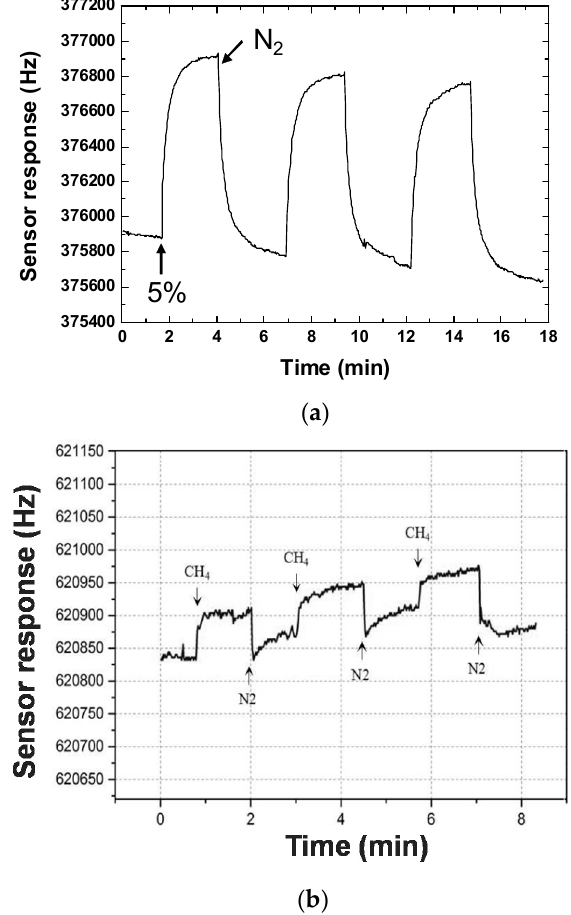
Figure 8. Sensor response and repeatability testing towards 5% CH 4 from the SAW sensor with different CrypA coating method. ( a ) Dropping-method; ( b ) Spinning-coating.